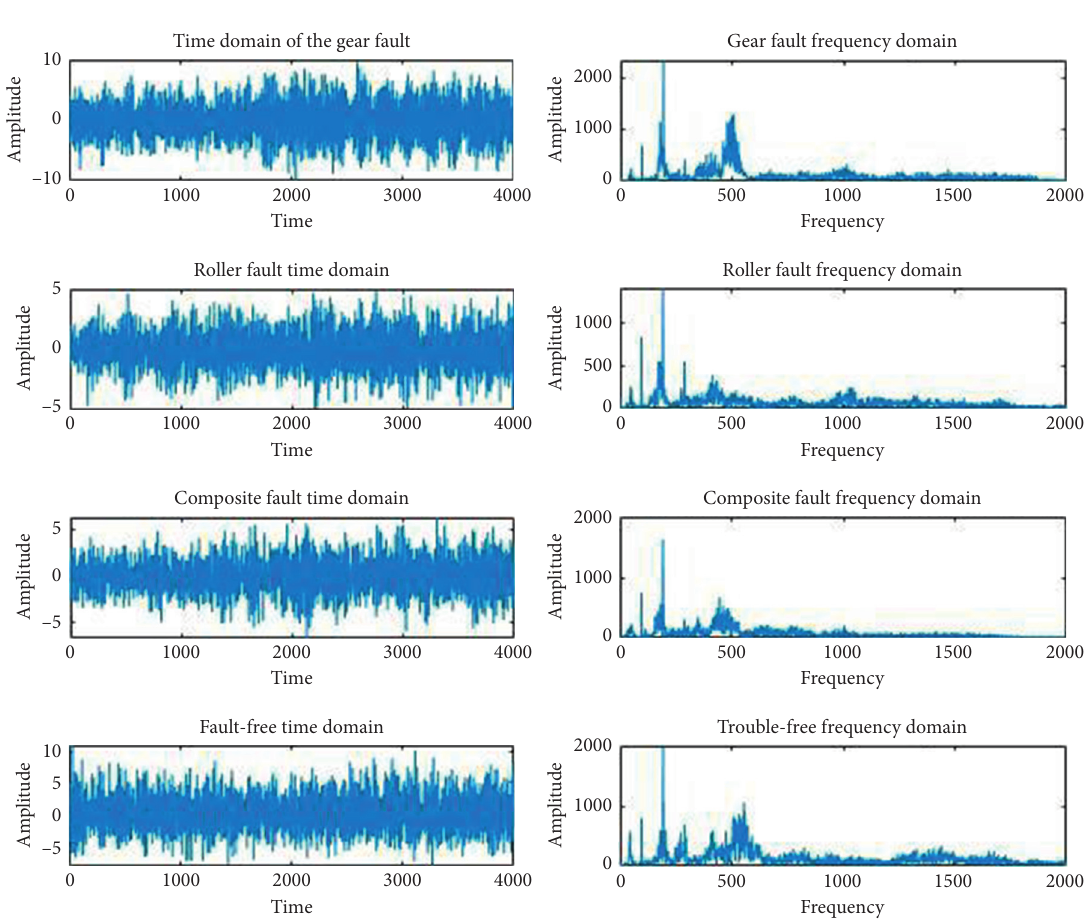
Figure 4: Time-frequency diagram of different